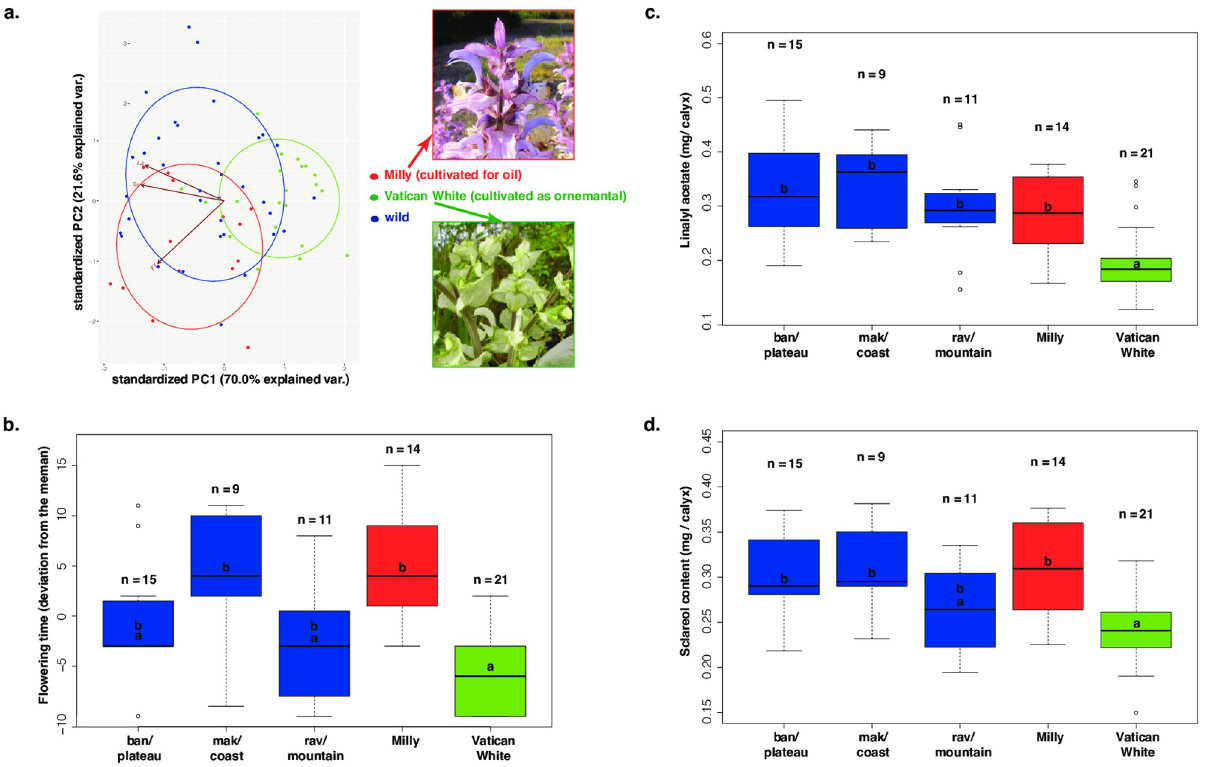
Fig 2. Phenotypic variation (for flowering time, sclareol and linalyl acetate contents) of the wild and cultivated clary sages ( Salvia sclarea L.) measured in the common garden at Chemille´ in France in 2018. a. Principal component analysis on phenotypic traits for the wild clary sages (blue), the Milly cultivar (red), and the White Vatican cultivar (green) with the photos of the flowers of representative Vatican White and Milly clary sage plants. b, c, d. Date of flowering (expressed in deviation from the mean), linalyl acetate and sclareol contents (expressed in mg/calyx), respectively, for each wild clary sage population (blue), the Milly cultivar (red), and the White Vatican cultivar (green). Numbers indicate the number of samples for each population, letters indicate the result of a Kruskal-Wallis rank test: values harboring the same letter are not significantly different.